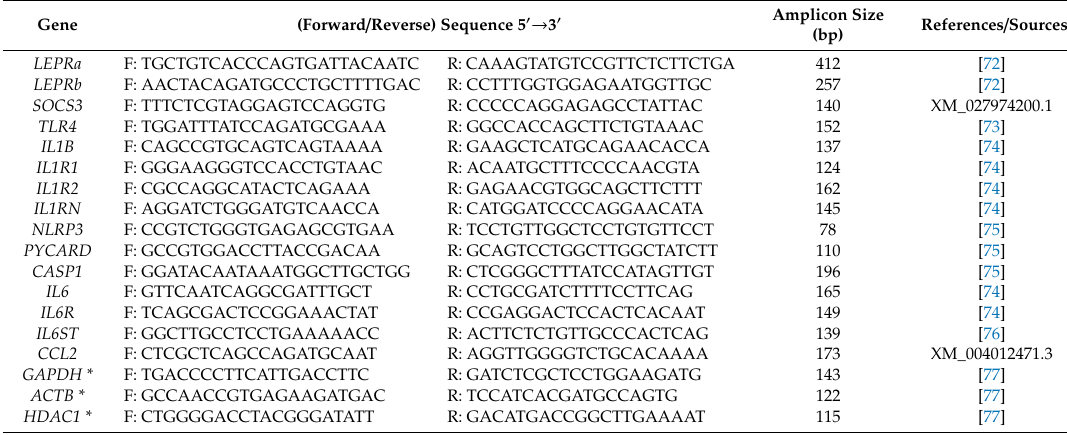
Table 1. Sequences of oligonucleotide primers used for real-time